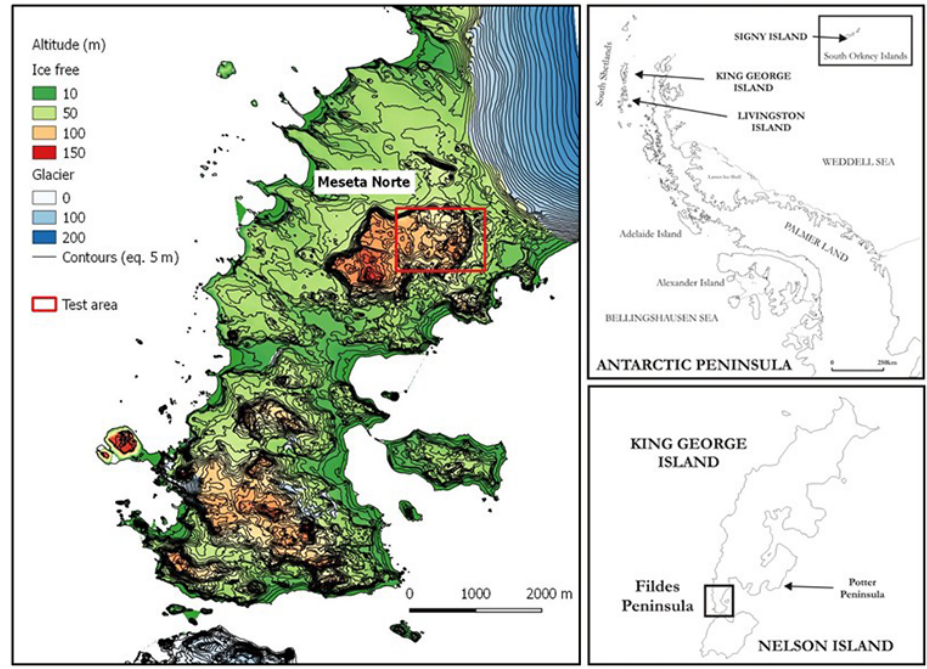
Figure 1. Location and topography of Fildes Peninsula and the Meseta Norte test site.